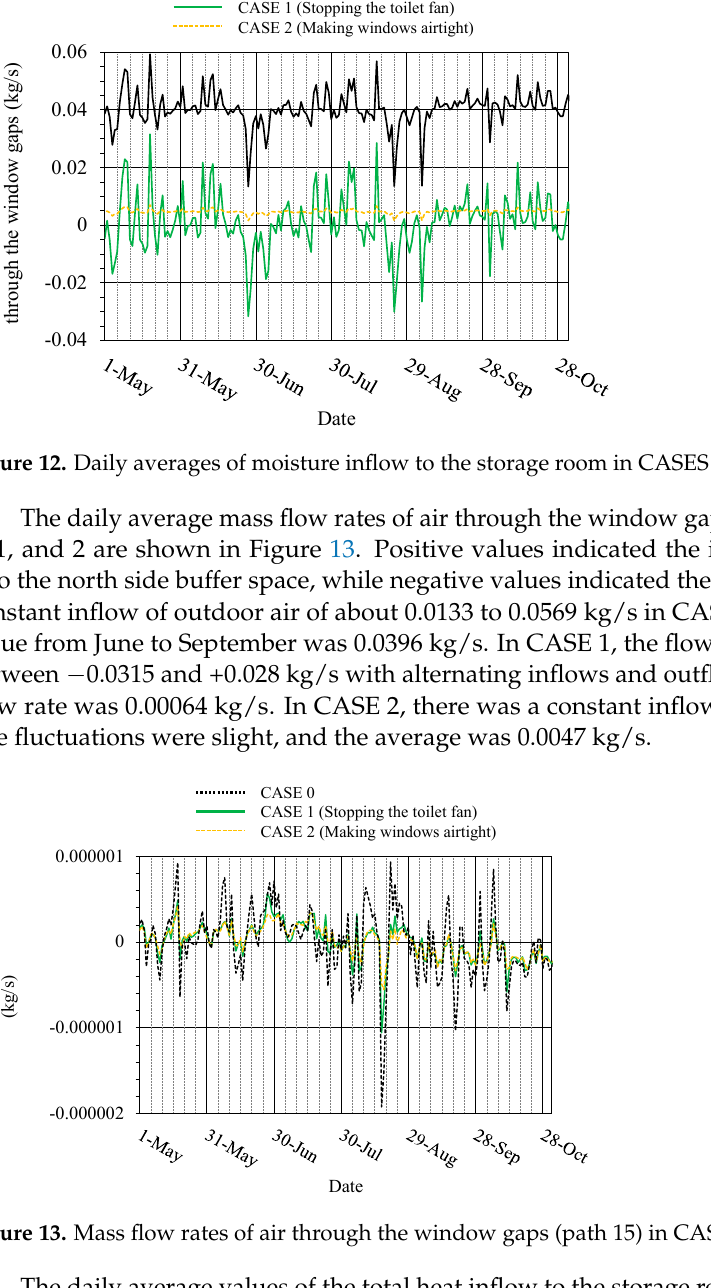
Figure 13. Mass flow rates of air through the window gaps (path 15) in CASES 0, 1, and 2. The daily average values of the total heat inflow to the storage room in CASES 3 and 4 are shown in Figure 14a,b, respectively. In CASE 3, the heat loss from the room through the ceiling was reduced by approximately 2.0 W compared to CASE 0. However, the heat flow through the other components decreased, and the total heat acquisition hardly increased (by 7.28 × 10 − 5 W on average). In CASE 4, the heat loss through the ceiling decreased by about 8.0 W compared to CASE 0, but the total heat acquisition did not increase (an average increase of 6.78 × 10 − 4